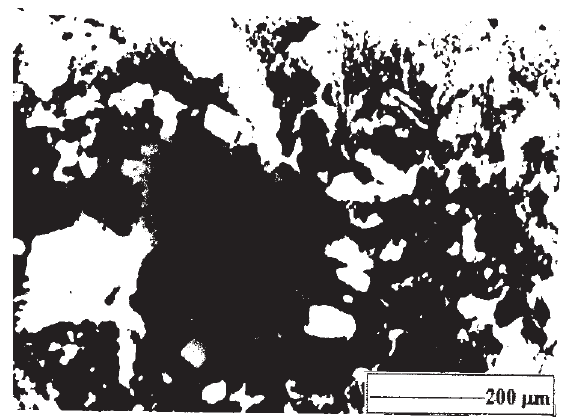
Figura 6. Matéria orgânica em diversos estádios de decomposição no horizonte A do perfil sob mata nativa (XPL).